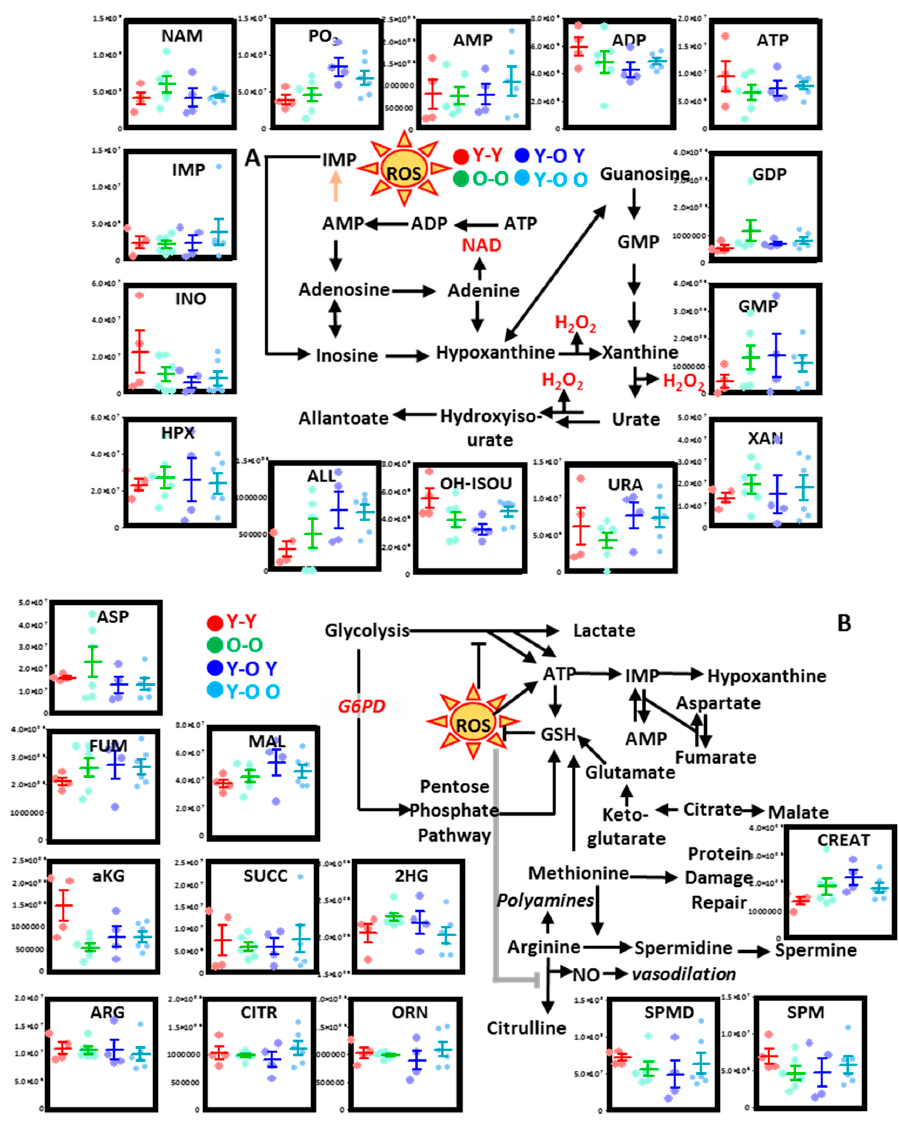
Figure 7. Alterations of RBC purine metabolism (A) , and carboxylic acid and arginine metabolism (B) in isochronic and heterochronic parabiotic mice. Dots represent distinct biological replicates for isochronic young–young (red) or old–old (green), or heterochronic Y–O mice with blood being drawn from the young mouse (blue) or the old mouse (light blue).